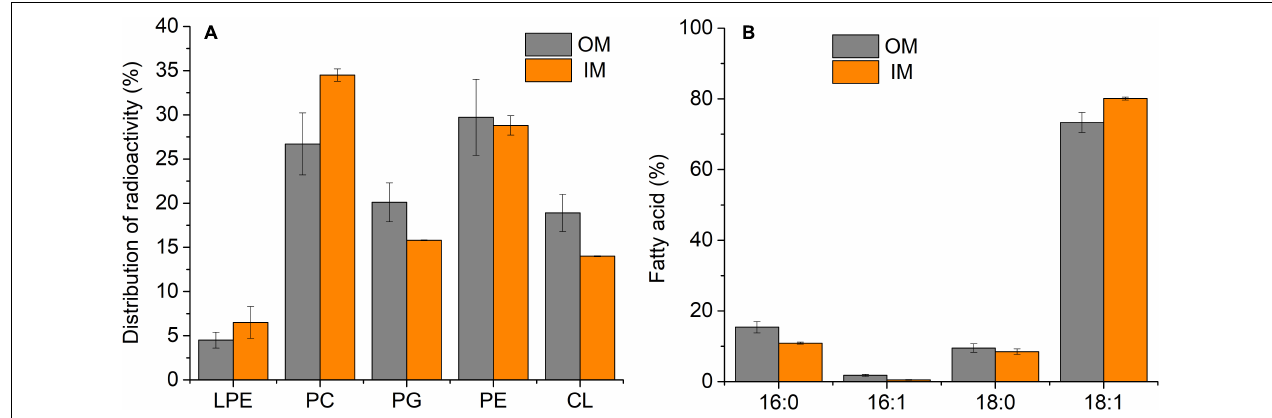
FIGURE 1 | PL (A) and FA (B) composition of S. meliloti OM and IM at 28 ◦ C (control). 50 mL of S. meliloti culture with or without [ 14 C]-acetate was grown to a stationary phase at 28 ◦ C. Afterward, OM and IM fractions were obtained. (A) Data from TLC of radioactively labeled PL bands scraped and quantified by liquid scintillation counting. (B) GC-MS analysis of FAME from total lipids. The percentage of each FA and PL is relative to the total defined as 100%. Values represent the mean ± sd of three independent